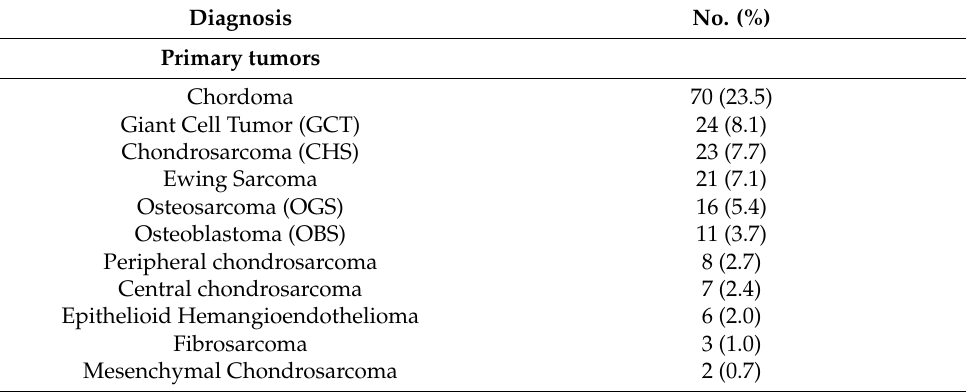
Table 3. Most frequent tumor histotypes in the study